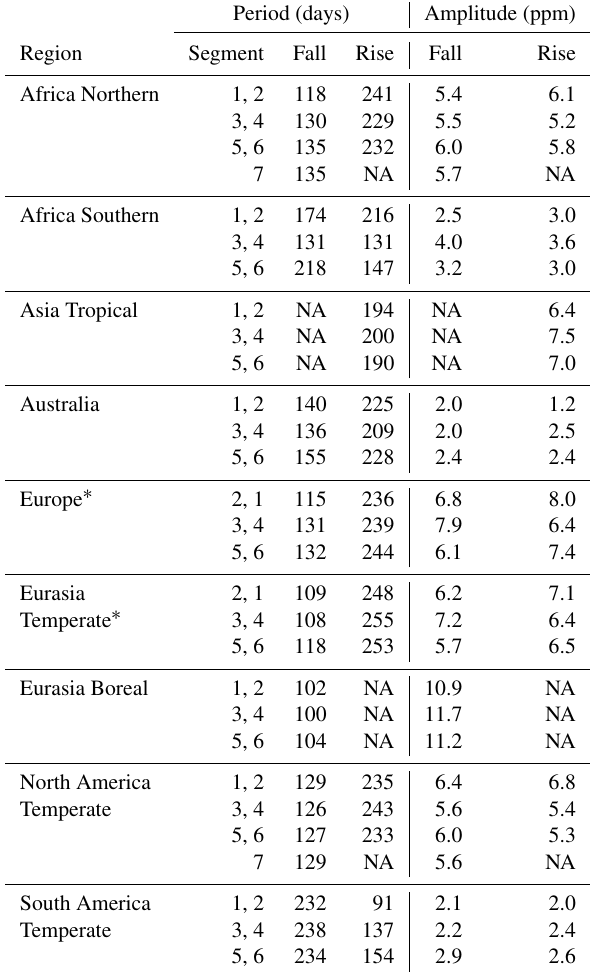
Table 2. Signal characteristics for rise and fall segments of the GOSAT-derived XCO 2 seasonal cycles (2009–2012) by TransCom region. The timeframe of one rise plus one fall segment approxi- mately equates to 1 year. North America Boreal and South Amer- ica Tropical regions were excluded for lacking the observations re- quired to derive signals for rise or fall